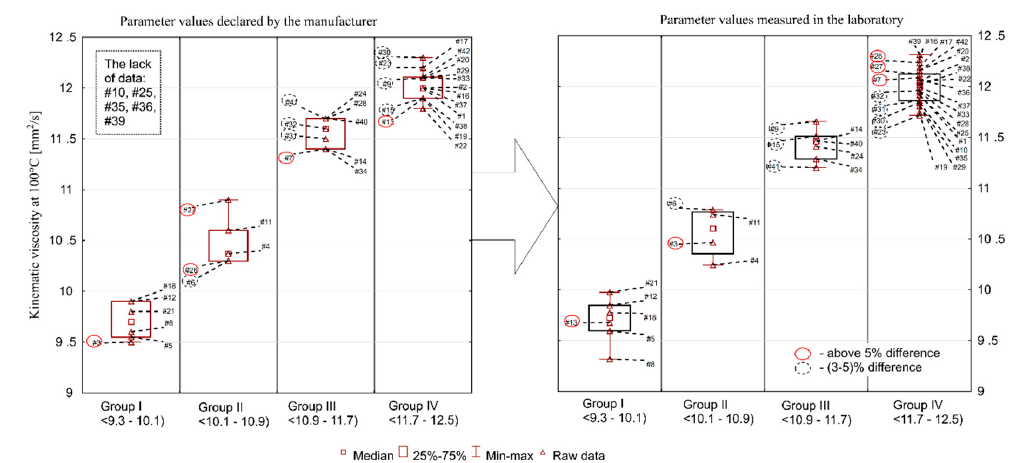
Figure 1. Kinematic viscosity at 40 °C. Figure 2. Kinematic viscosity at 100 °C.